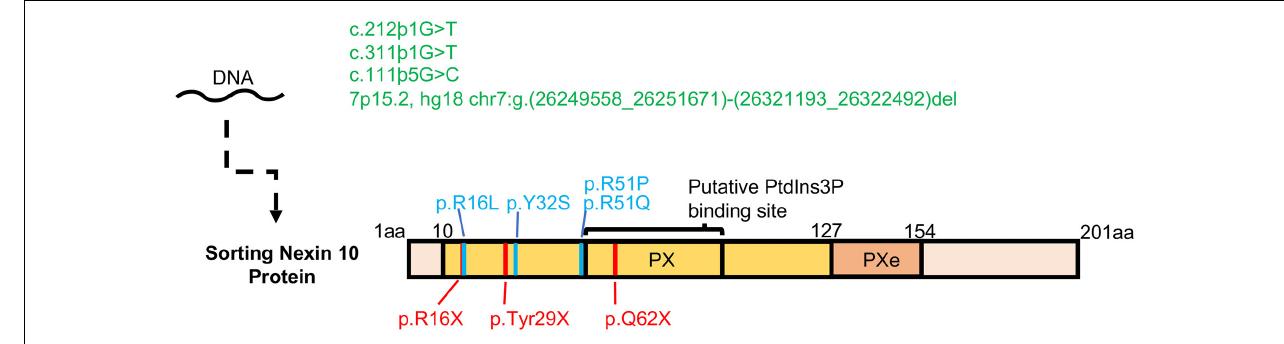
FIGURE 2 | Osteopetrotic mutations in SNX10. Three mutations that affect exon splicing and a large scale deletion in the SNX10 locus are shown in green. Non-sense mutations leading to an early stop codon, which may produce a highly truncated and potentially unstable protein product are shown in red. Known missense mutations, which may affect the stability of the SNX10 protein or its ability to bind lipids and proteins, are shown in blue. A compound heterozygous nonsense mutation of p.Q62X with p.R16L has also been described. The PX and Pxe (extended PX domain, Xu et al., 2014 Proteins 82, 3483-3489, 2014) are marked in yellow and orange,